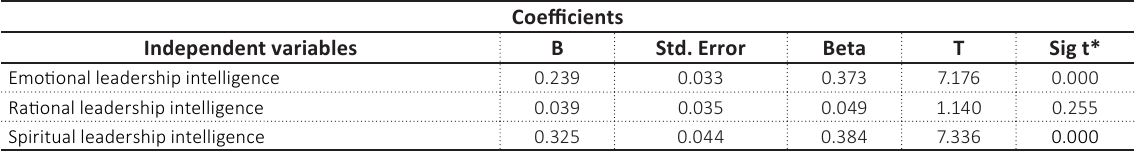
Table 5. Regression coefficients for